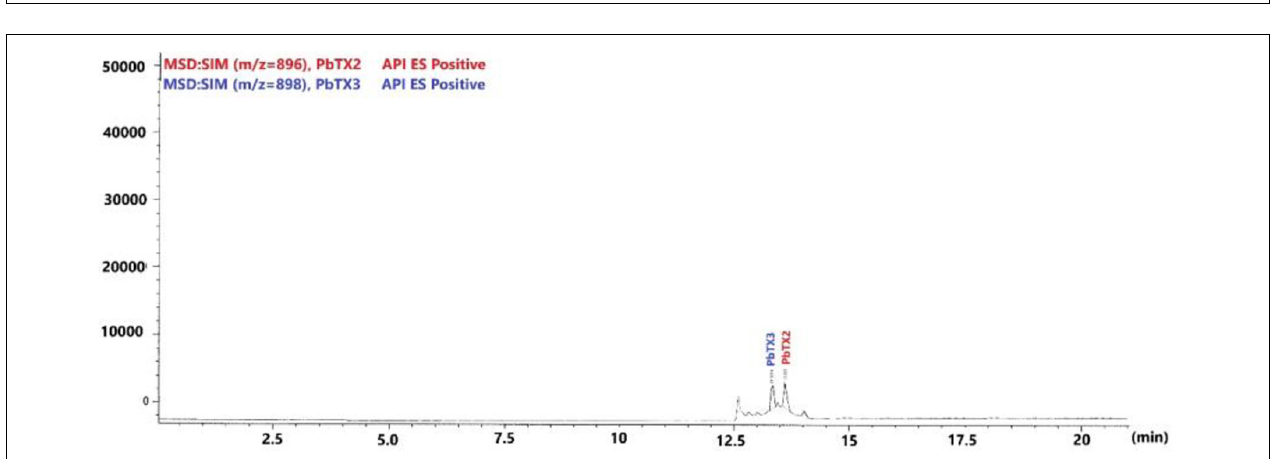
FIGURE 4 | Chromatogram from liquid chromatography–mass spectrometry (LC-MS) analysis of liver extract from case #6.